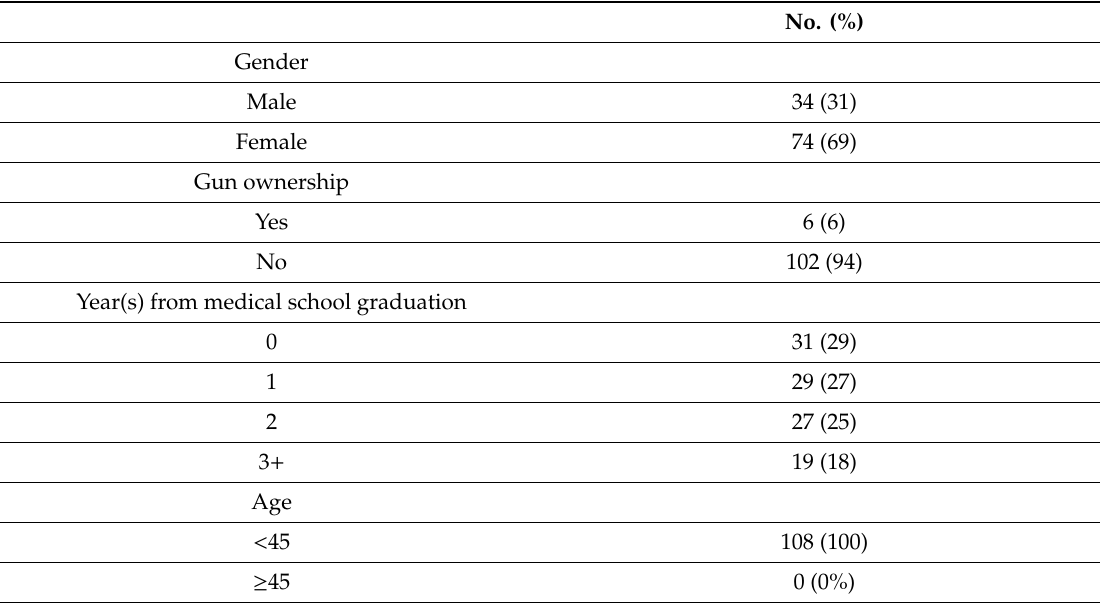
Table 1. Demographics of